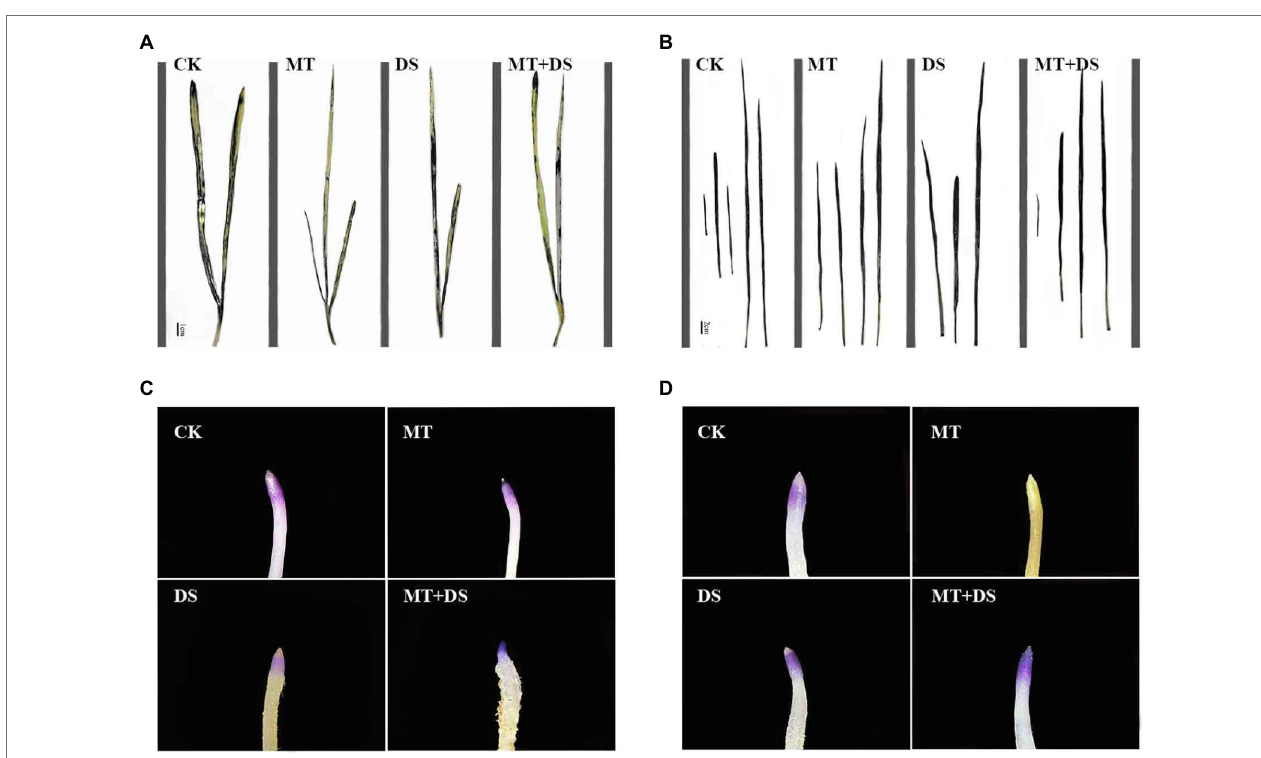
FIGURE 13 | NBT histochemical detection of O 2 − in triticale plant parts. (A) Leaf staining on 10 th day, (B) leaf staining on 20 th day, (C) root staining on 10 th day and (D) root staining on 20 th day. To visualize the NBT deposits, leaves were decolorized in boiling ethanol and the blue deposits of O 2 − in form of spots were quantified.